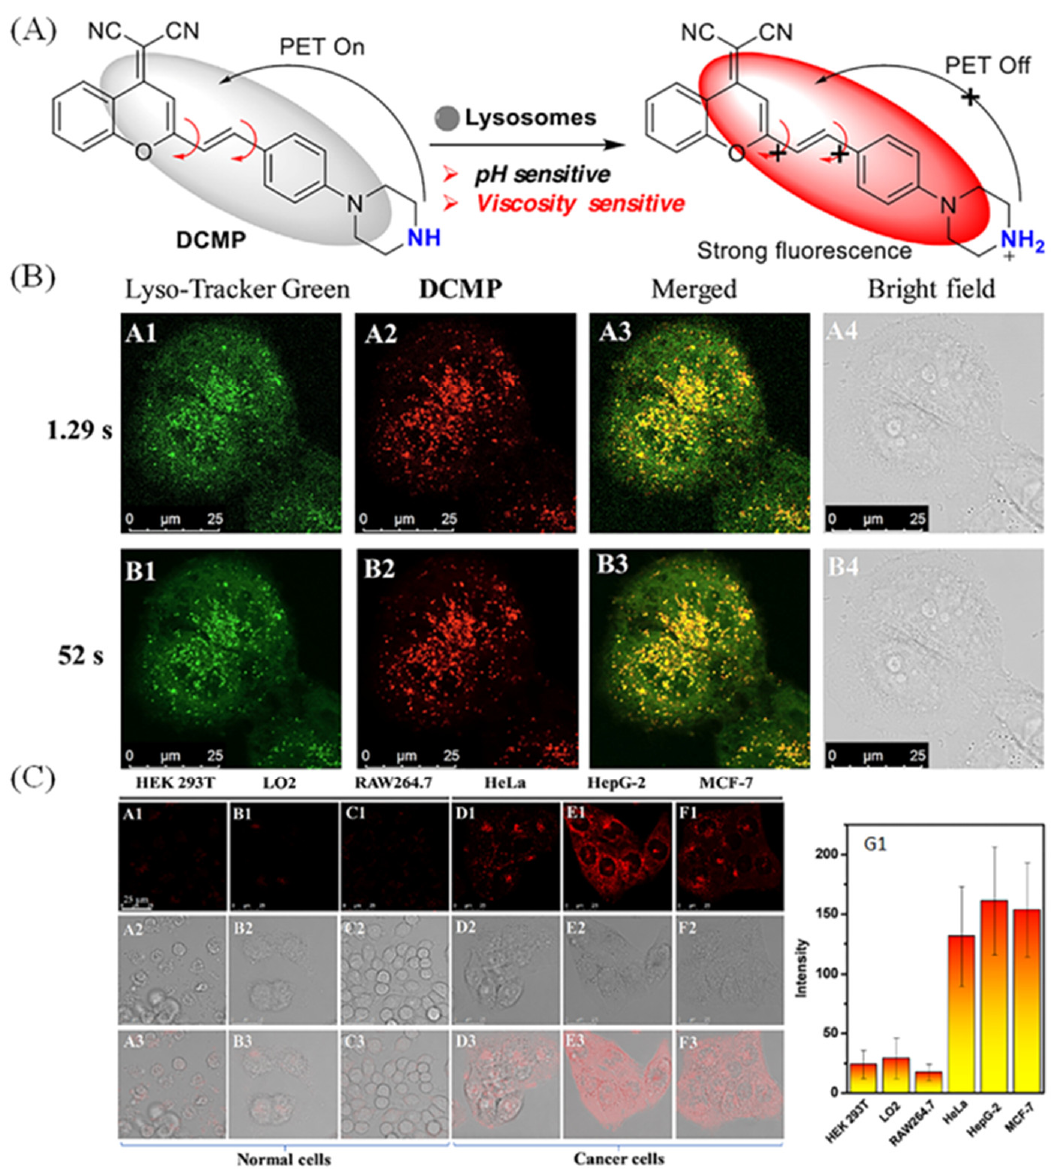
Figure 9. ( A ) The design mechanisms of DCMP sensitive to viscosity. ( B ) Co-staining fluorescence pictures of Lyso-Tracker Green (200 nM, A1 , B1 ) and DCMP (100 nM, A2 , B2 ) under different scanning speed (exposure time 1.29 s and 52 s). A3 , B3 : the merged pictures of A1 , A2 and B1 , B2 . ( C ) Fluorescent pictures of different types of cell line (cancer cells: HepG-2, HeLa, and MCF-7; normal cells: LO2, HEK 293 T, and RAW264.7) staining with DCMP (100 nM) and their relative intensity ( G1 ) of different cells. A1 – F1 : confocal pictures of cells; A2 – F2 : DIC pictures; A3 – F3 : the corresponding pictures of A1 – F1 and A2 – F2 . Reproduced from Ref. [51] with permission of the Elsevier, copyright 2022.